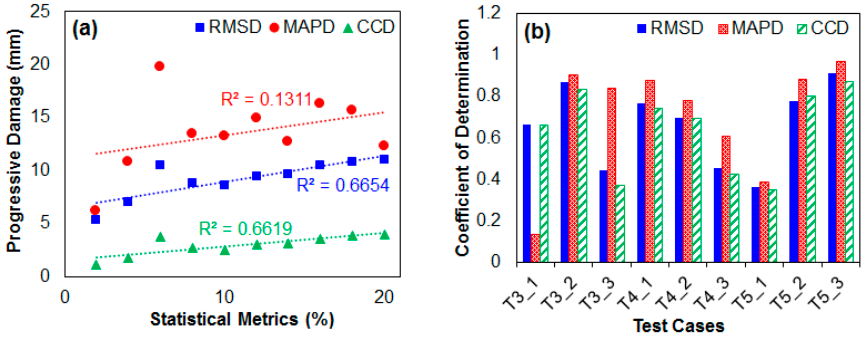
Figure 9. Results for ( a ) T3_1 statistical metric values; ( b ) T3_x, T4_x and T5_x R 2